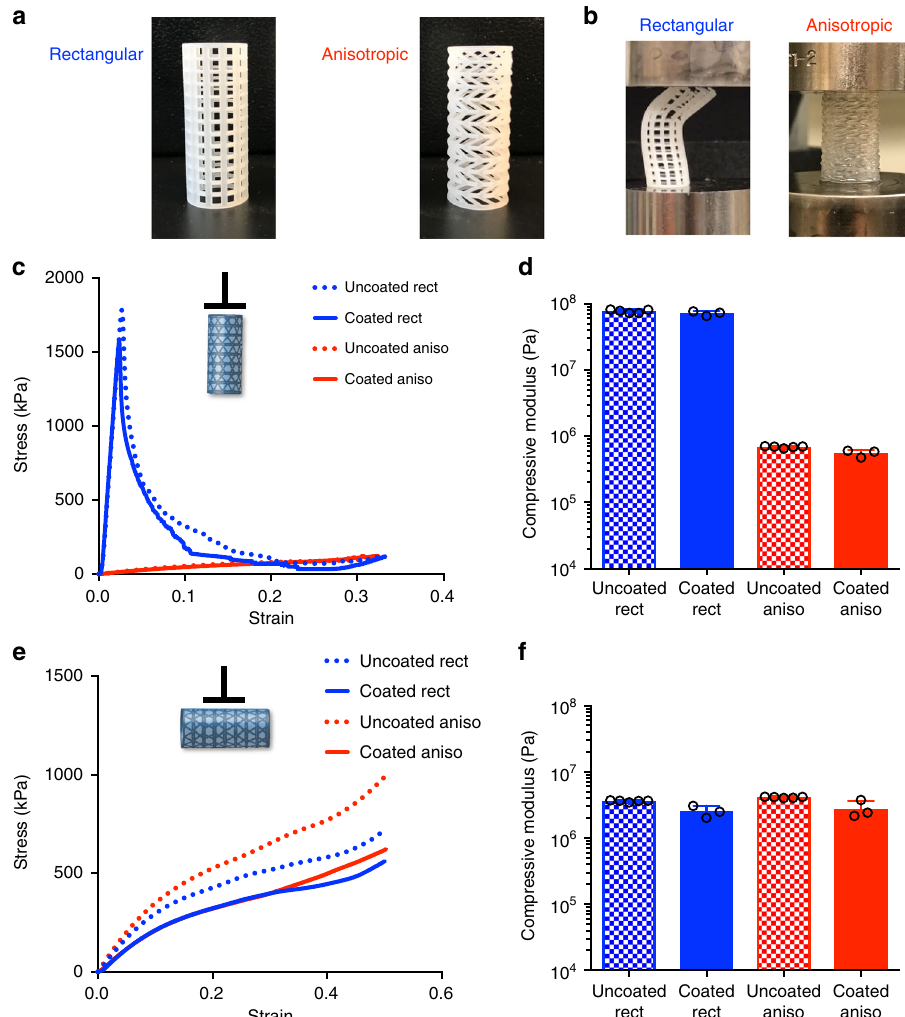
Fig. 5 Mechanical characterization of cylindrical materials. a Two similar cylinders were produced via 3D printing with rectangular window geometry (rectangular; Rect) or parallelogram window geometry (anisotropic; Aniso). b Still images of the rectangular and anisotropic cylinders during longitudinal compression. Rectangular devices buckled and failed at low strain while anisotropic devices compressed up to ~30% strain without failure with or without a hydrogel coating (image shown with coating). c Stress – strain curves under longitudinal compression for uncoated (dashed lines) and coated (solid lines) rectangular (blue) and anisotropic (red) scaffolds. d Effective compressive moduli under longitudinal compression for uncoated (patterned bars) and coated (solid bars) rectangular (blue) and anisotropic (red) scaffolds. e Stress – strain curves under radial compression for uncoated (dashed lines) and coated (solid lines) rectangular (blue) and anisotropic (red) scaffolds. f Effective compressive moduli under radial compression for uncoated (patterned bars) and coated (solid bars) rectangular (blue) and anisotropic (red) scaffolds. The plots show a single representative stress – strain curve for each scaffold type. Compressive moduli values are displayed as mean + s.d. ( n = 5 for uncoated scaffolds and n = 3 for coated